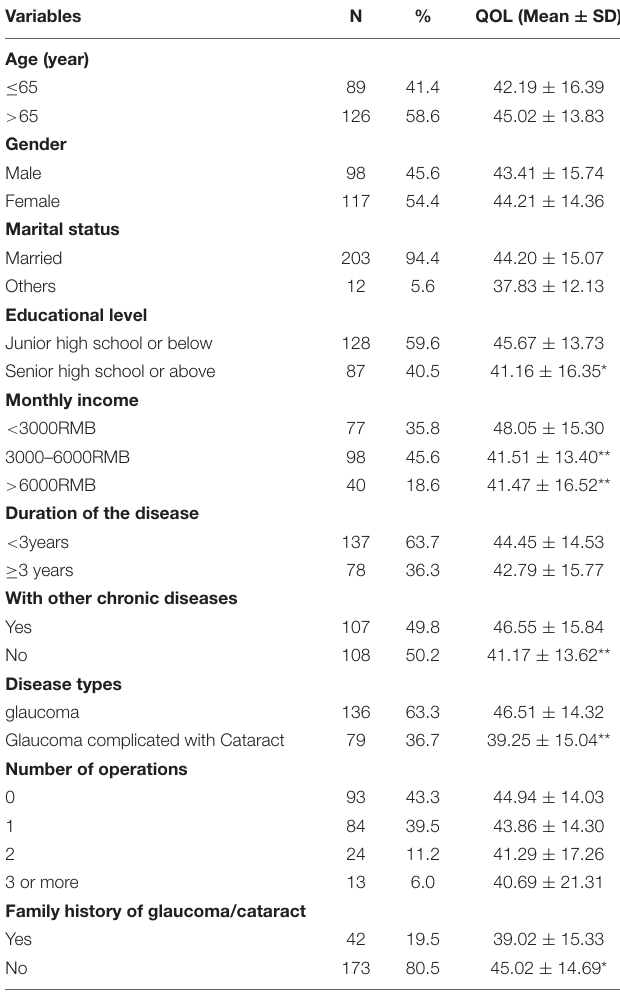
TABLE 1 | Demographic characteristics and clinical information of glaucoma patients and distributions of QoL.